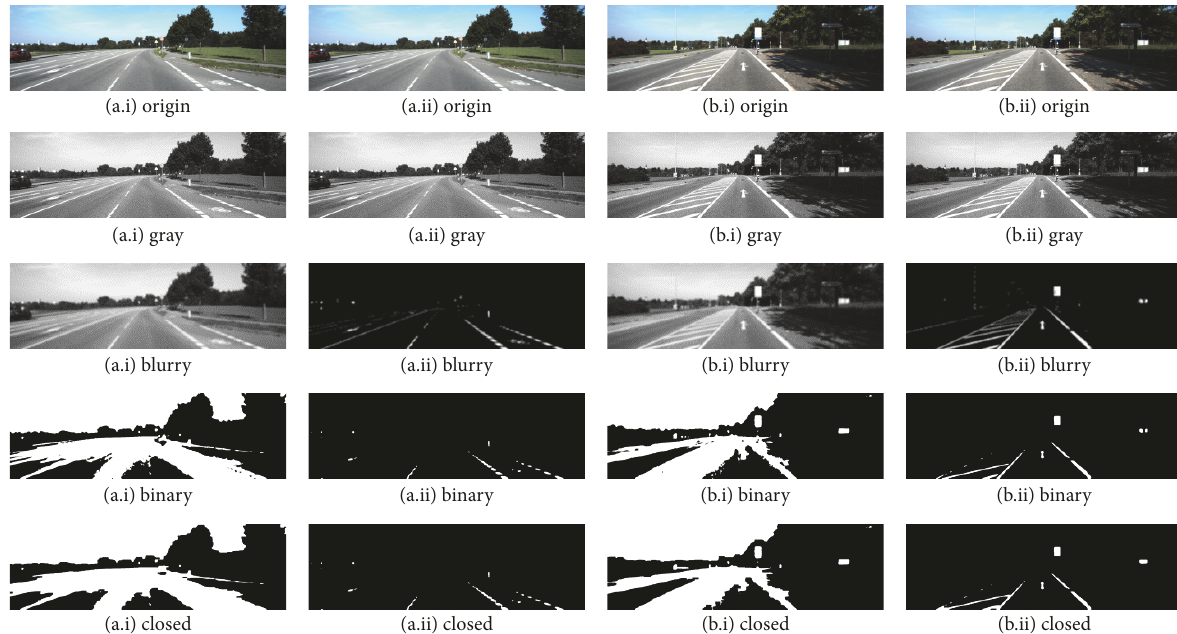
Figure 15: Comparison between the basic preprocessingmethod and the proposed preprocessing method. ((a.i)and (b.i))Without extracting white before blurry one (the basic preprocessing method) and (a.ii) and (b.ii) with extracting white before blurry one (the proposed preprocessing